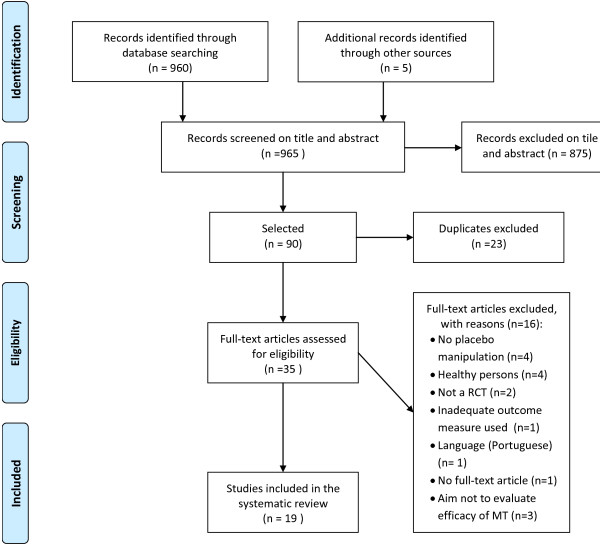
Flowchart of the inclusion and exclusion of RCTs.